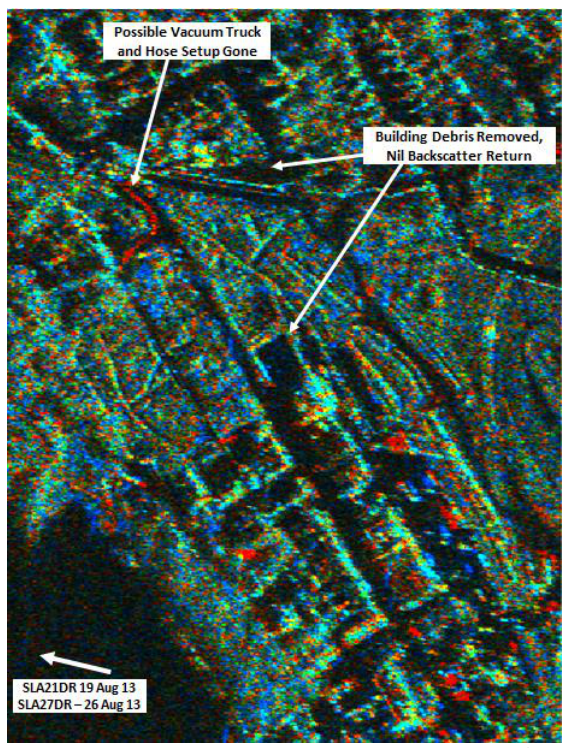
Figure 18. Comparing change between image dates of 19 September, 2013 and 29 September, 2013. RADARSAT-2 Data and Products © MacDonald, Dettwiler and Associates Ltd. 2013. All Rights Reserved. RADARSAT is an official mark of the Canadian Space Agency.